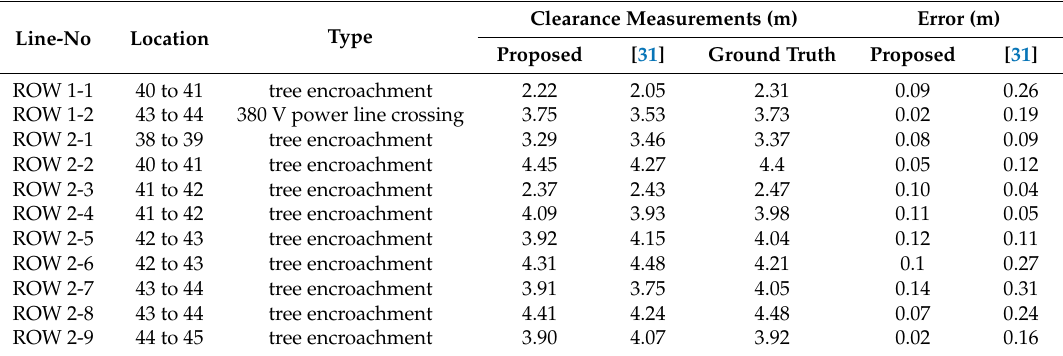
Table 5. Clearance anomalies detection